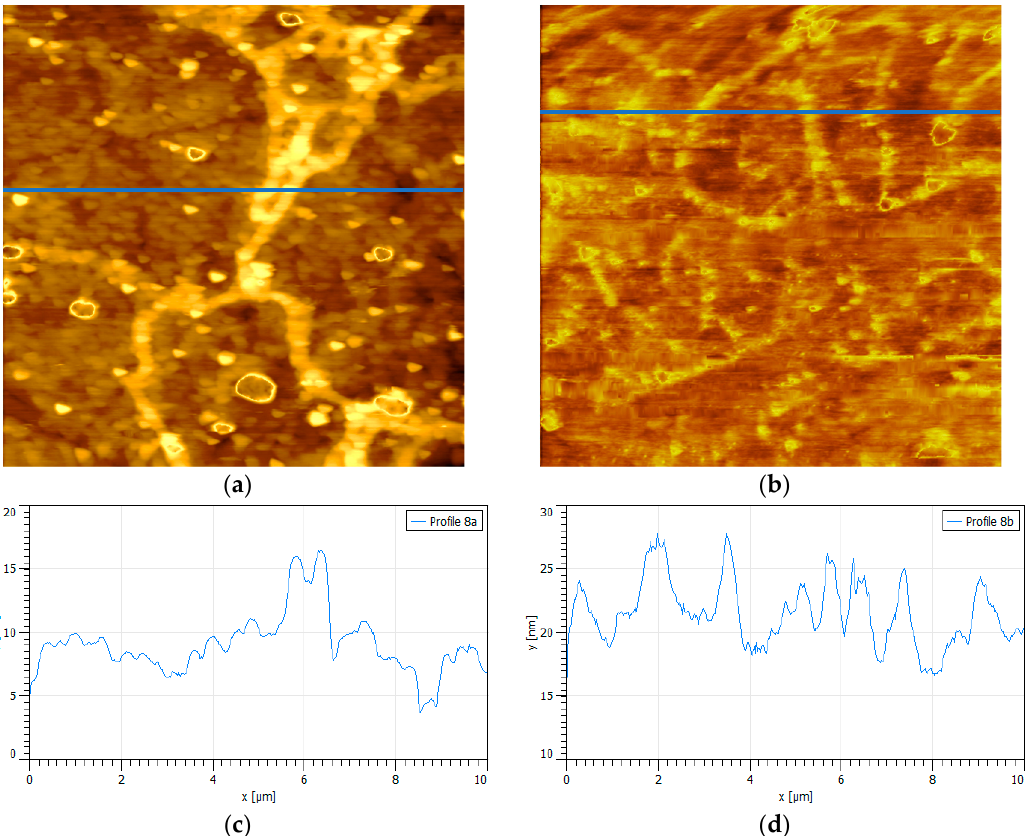
Figure 6. Surfaces {100} of oxidized pyrite exposed to PAX and calcium chloride at pH 8.5, scan size is 10 × 10 µ m 2 . ( a ) 0.01 M CaCl 2 , 10 − 4 M PAX; ( b ) 0.5 M CaCl 2 , 10 − 4 M PAX, pH 8.5, ( c ) and ( d ) are the corresponding height profiles (blue line in the images).